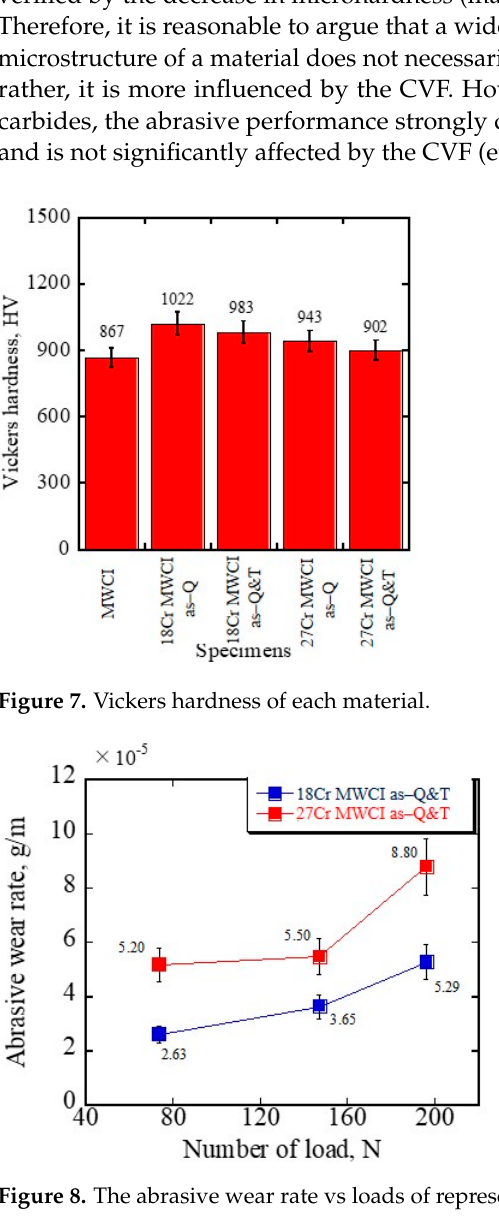
Figure 8. The abrasive wear rate vs loads of representative materials.